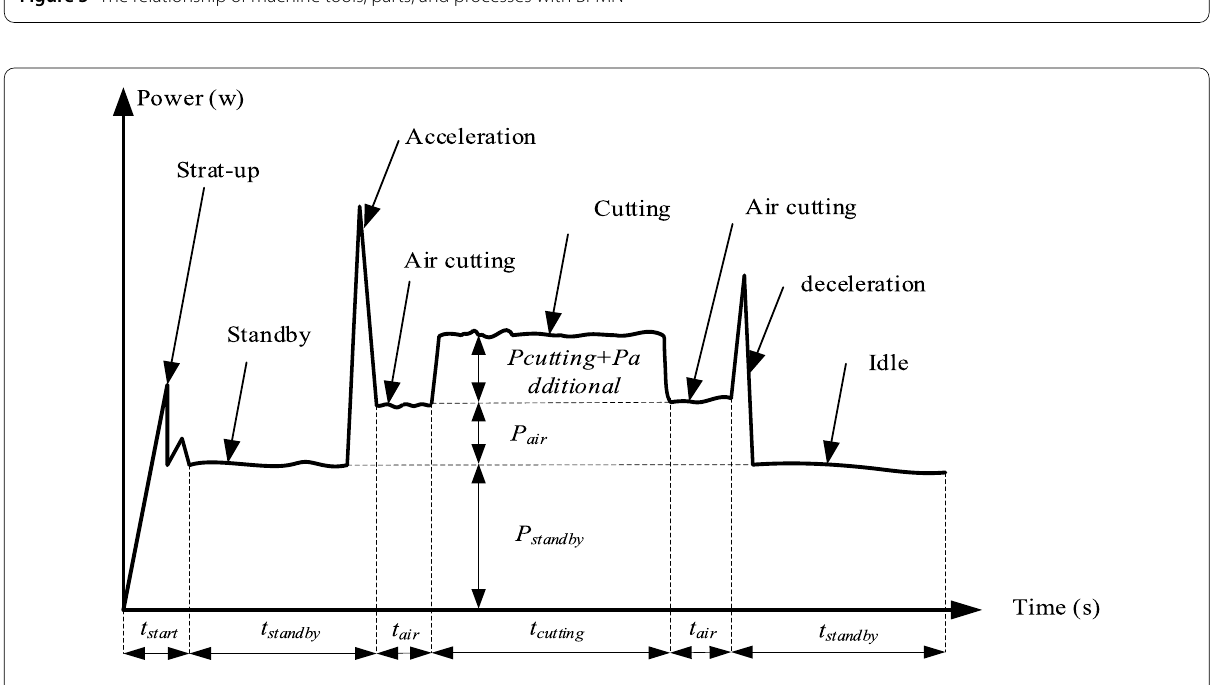
this correlation, as shown in Eq. (4)–Eq.